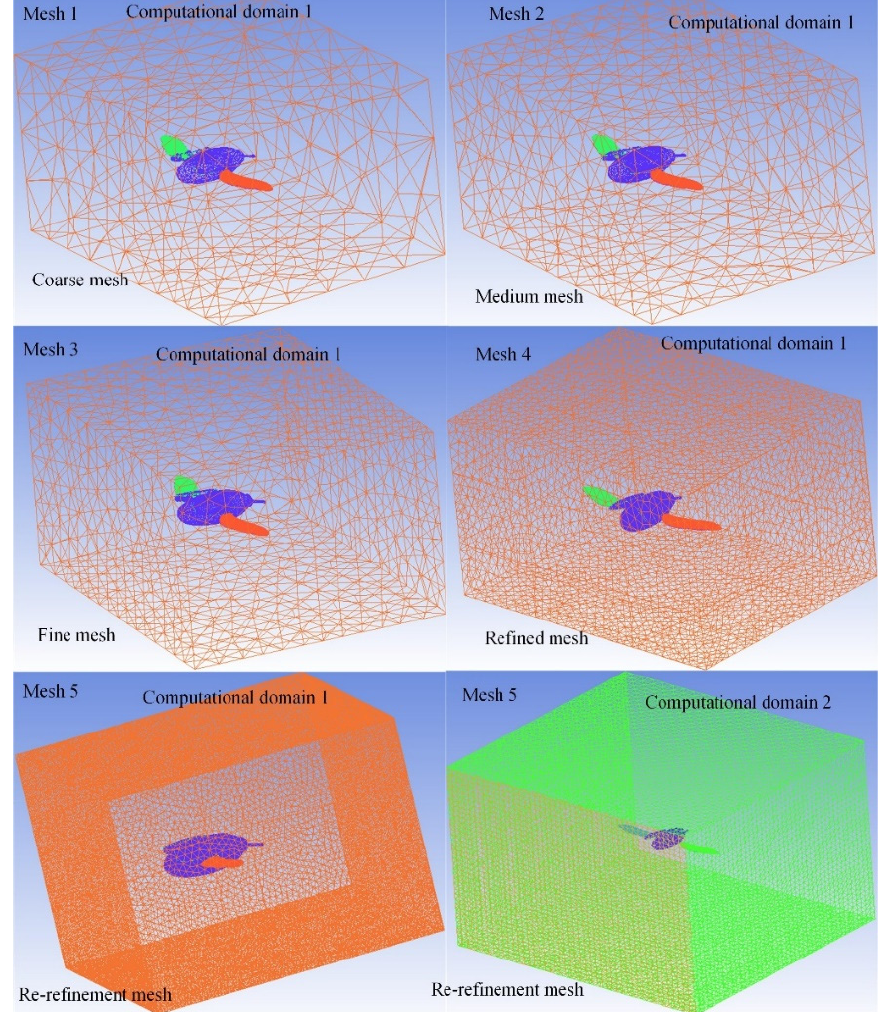
Figure 3. Demonstration of five different mesh systems and two different computational domains. The primary simulation results are shown in Figure 4. The element size increased by 37% when the mesh was refined from coarse mesh to medium mesh. The changes in lift characteristics, from a coarse grid system to a refined grid system, manifested as a significant difference between the lift curves. The lift from the refined grid system to the re-refinement grid system does not change significantly, and the difference between the average values of the vertical forces is about 2%. Furthermore, the difference in the mean lift between computational domain 1 (time step size: 0.00001) and computational domain 2 (time step size: 0.000001) of the re-refinement grid system is less than 1%. Therefore, for the computational domain 1, the number of elements and nodes of the computing model significantly increased from the refined mesh model to the re-refinement mesh system. The difference in lift and drag from computational domain 1 to computational domain 2 is small, and the simulation model only increases the size and number of elements in